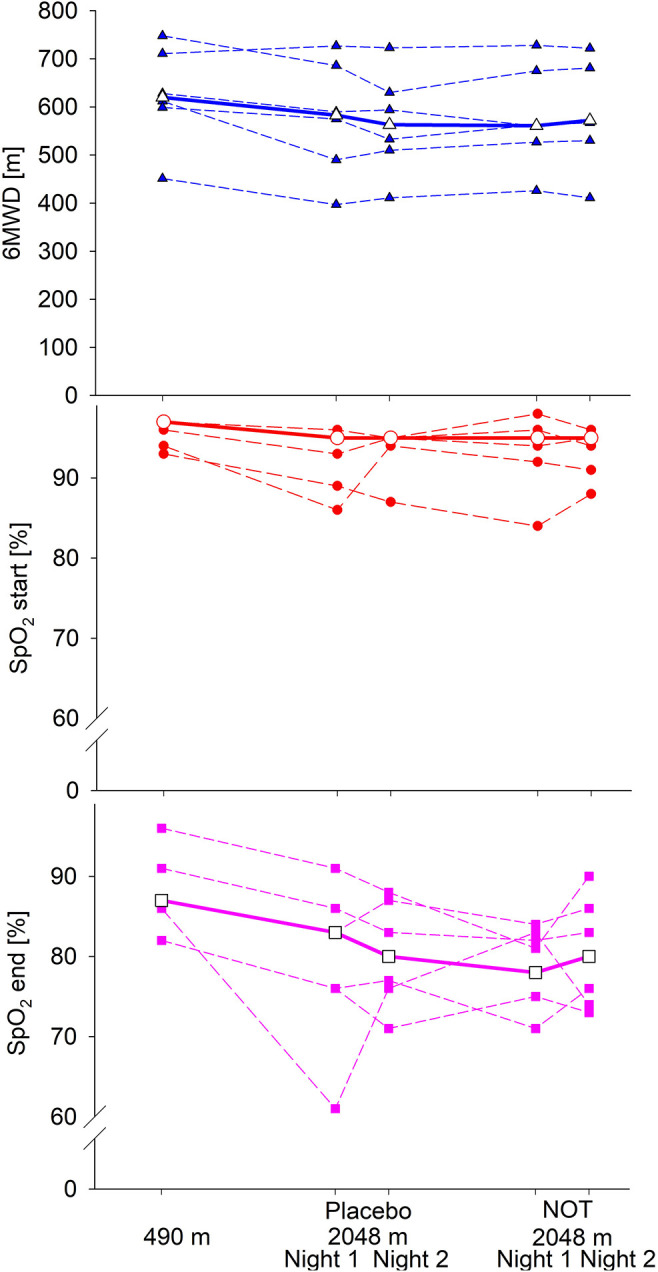
Sleep study results of the patients who completed the study are shown. SpO2, oxygen saturation; ODI, oxygen desaturation index; AHI, apnea/hypopnea index; Bold, median.